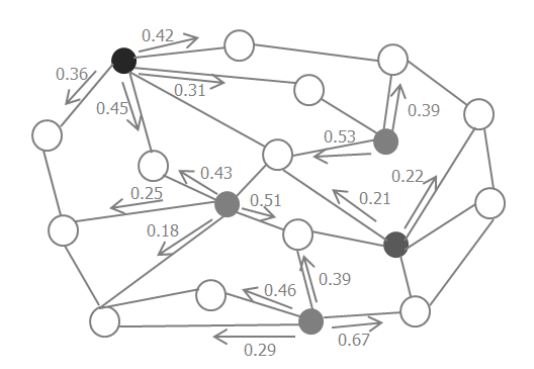
Figure 1. Procedure of label